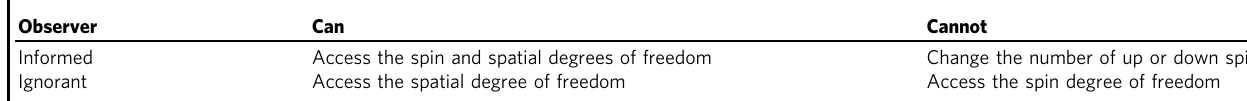
Table 1 Summary of the observers ’ abilities. Observer